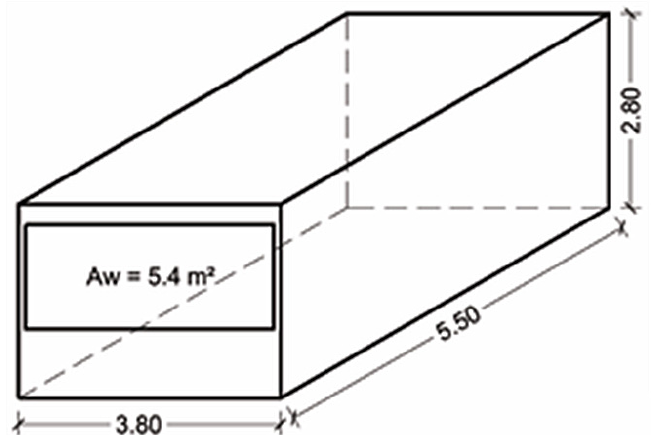
Figure 5. Axonometric plan of the reference room [3].